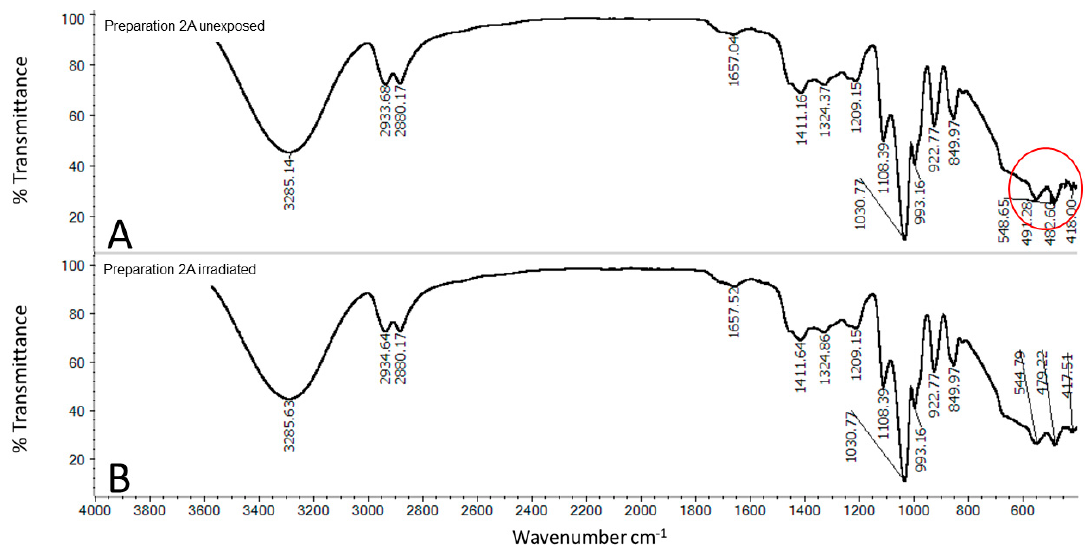
Figure 6. FTIR spectrum of freeze-dried preparation: ( A ) unexposed Preparation 2A, ( B ) irradiated Preparation 2A; composition of the Preparation 2A is given in the Table